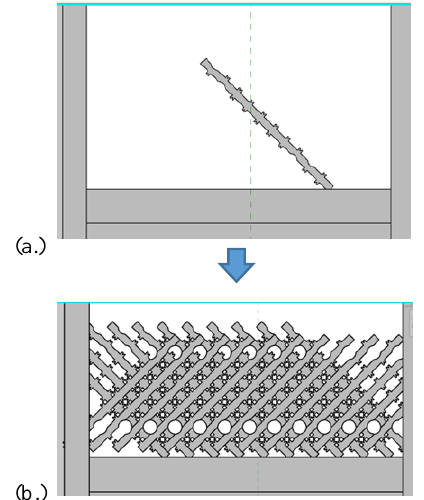
Figure 12. Modelling the Manjur pattern in 3-D. (a.) Modelling the first part of the Manjur. (b.) Combining the Manjur parts.